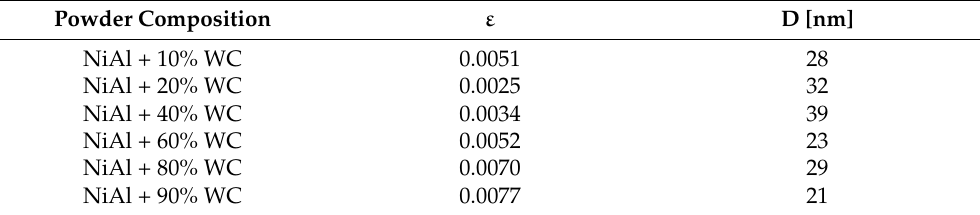
Table 3. Estimated size and strain factors based on Williamson–Hall plots for NiAl-xWC powders after 10 h of mechanical